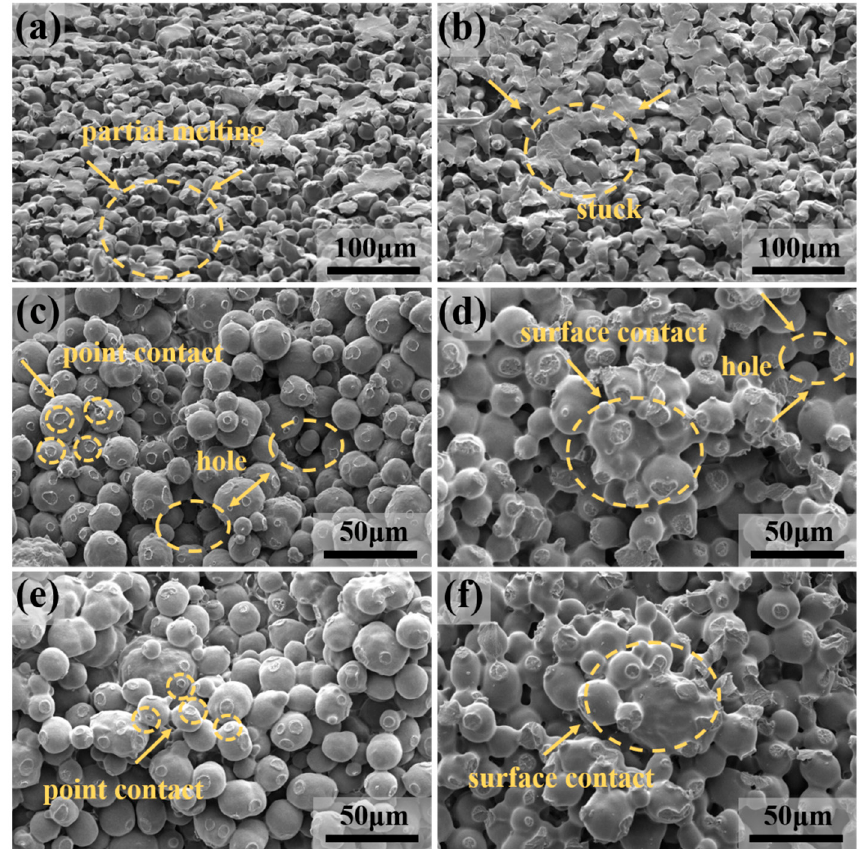
Figure 3. The microstructure of the sample under different sintering temperatures: ( a , b ) Surface microstructure of sample under the molding condition of rotary sintering at 170 °C and 200 °C, respectively, where the arrows indicate the melting of samples; ( c , d ) cross-sectional microstructure of sample under the molding condition of static sintering at 170 °C and 200 °C, respectively, with the charging amount of 3 g; ( e , f ) cross-sectional microstructure of sample under the molding condition of rotary sintering at 170 °C and 200 °C, respectively, with the charging amount of 4 g. Arrows in ( c – f ) indicate the melting and the contact mode between the particles and the difference in porous structure of samples obtained by rotary and static sintering methods.